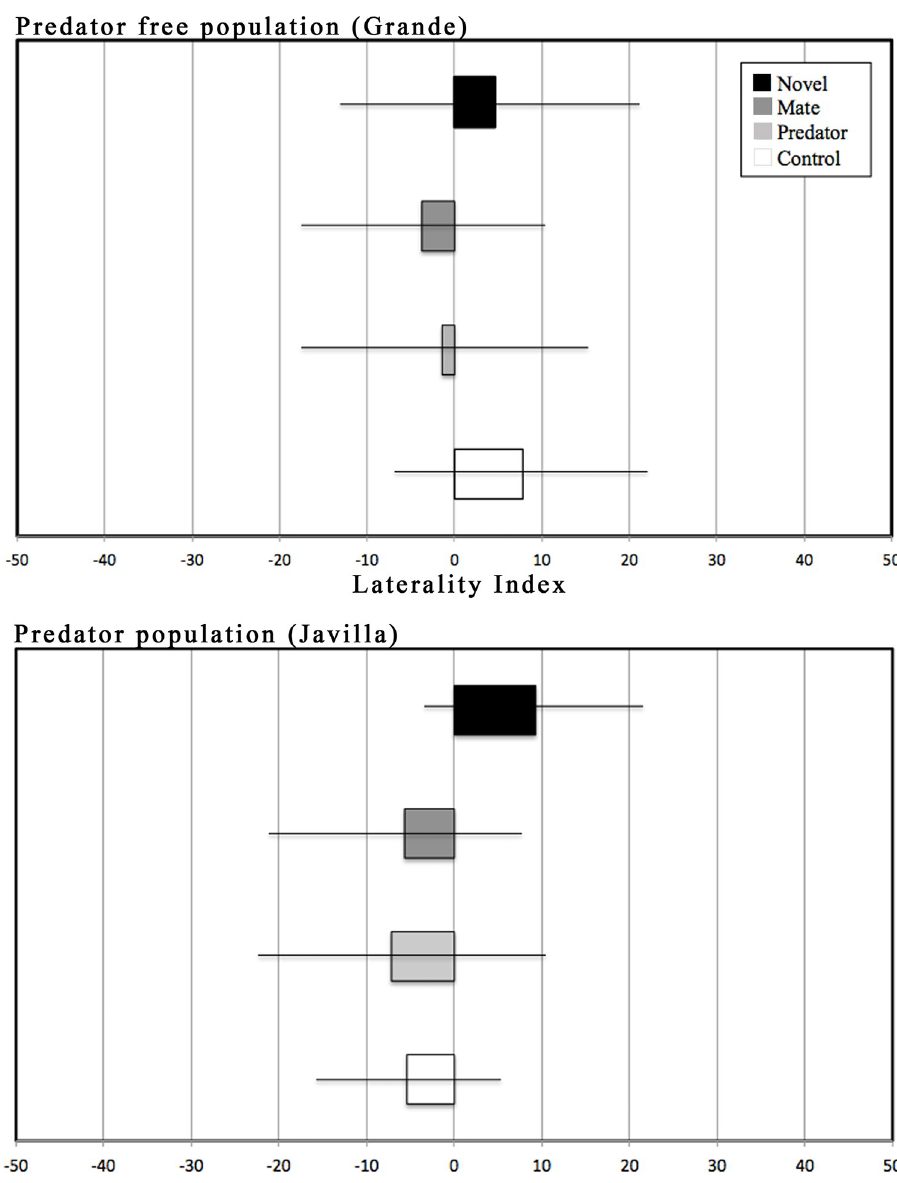
Fig 2. Detour tank arena. S = stimulus. See Johnson et al.